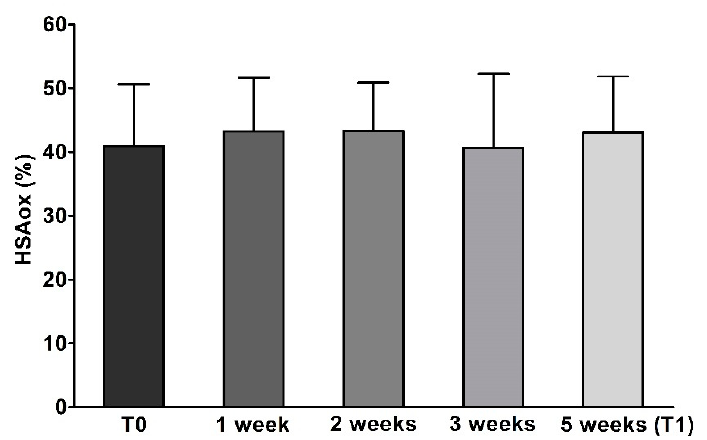
Figure 1. Human oxidized serum albumin in chronic kidney disease patients. The bars (five shades of grey) represent the values HSAox determined at various times (T0, 1 week, 2 weeks, 3 weeks, and 5 weeks—T1) for CKD patients ( N = 21). Values are reported as mean ± standard